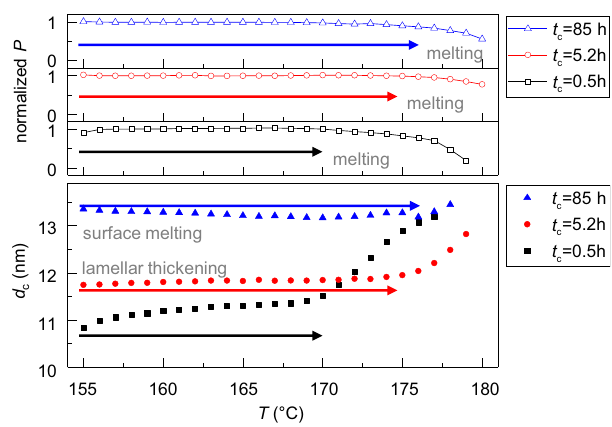
Fig. 5 Effect of crystallization time on melting temperature. Porod parameter P and crystal thickness d c of POM130 during stepwise heating after isothermal crystallization at 155°C for different crystallization times: t c = 0.5h (black), t c = 5.2h (red), and t c = 85h (blue). The arrows indicate the temperature range between the crystallization temperature and the temperature at which melting sets in as indicated by the decreasing values of P for the different values of t fi c . Source data are provided as a Source Data